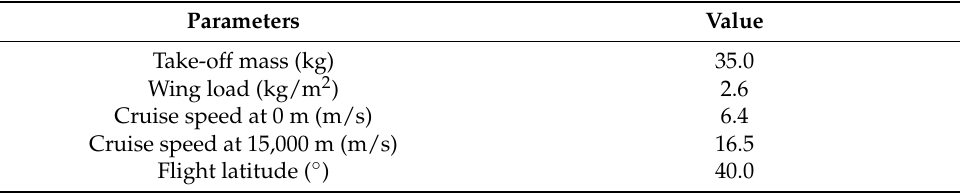
Table 1. The primary aerodynamic parameters at different